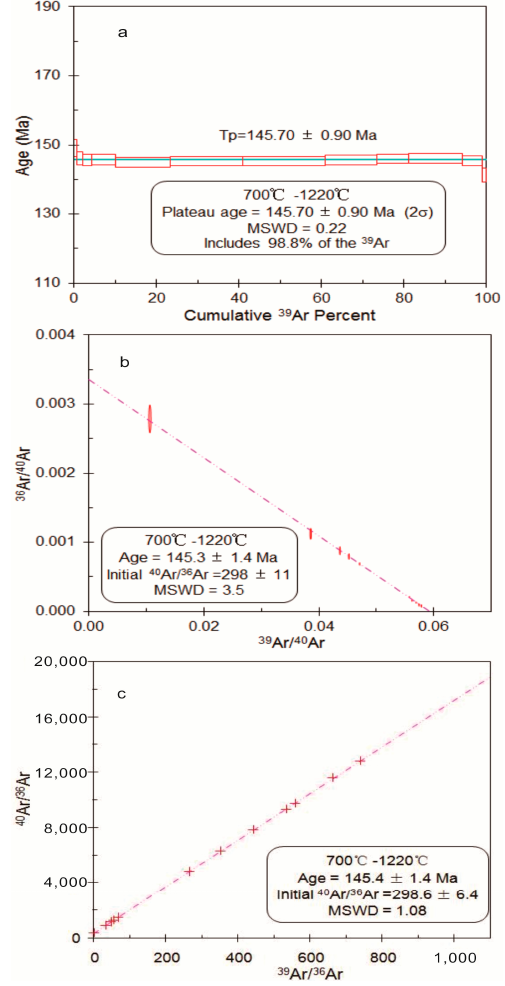
Figure 3. ( a ) Plateau, ( b ) inverse and ( c ) normal isochron muscovite Ar-Ar isotopic age of the Shimensi deposit.